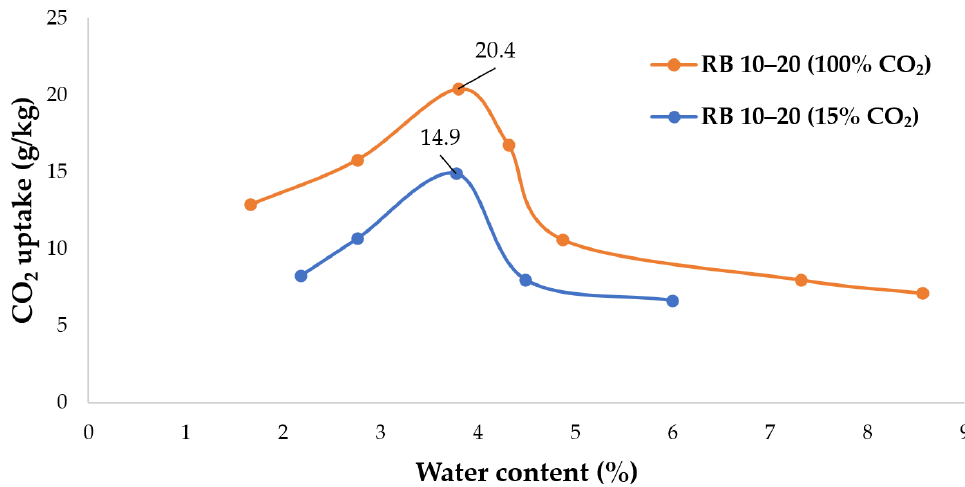
Figure 6. Effect of the CO 2 concentration on CO 2 uptake as a function of the water content (one accelerated carbonation test for these RCAs at the same water content).